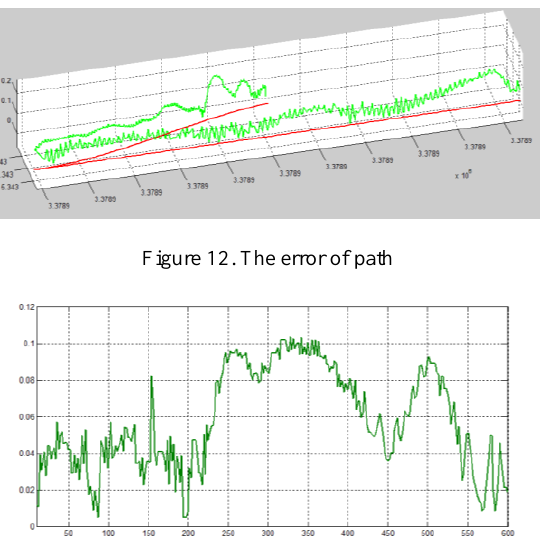
Figure 13. Specific difference of path